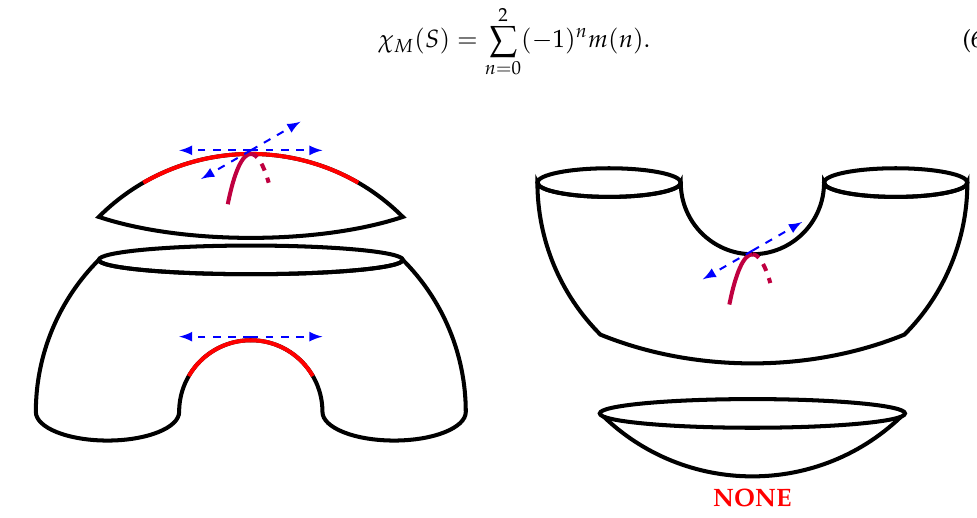
Figure 10. Principal descending directions from the critical points at any piece.